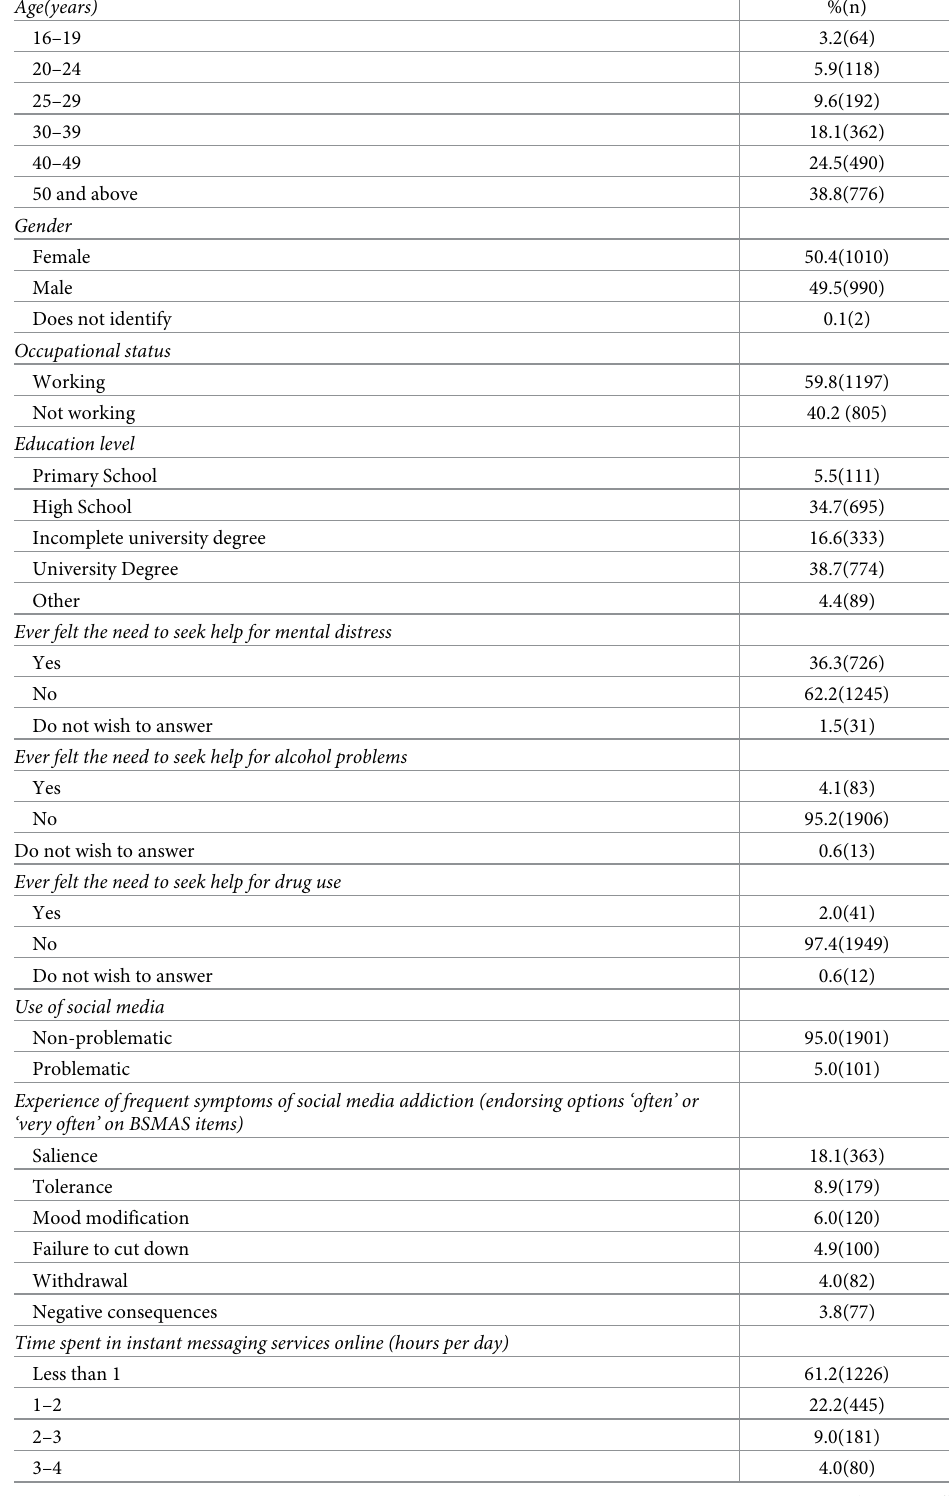
Table 1. Description of the study sample. All individuals included (N =